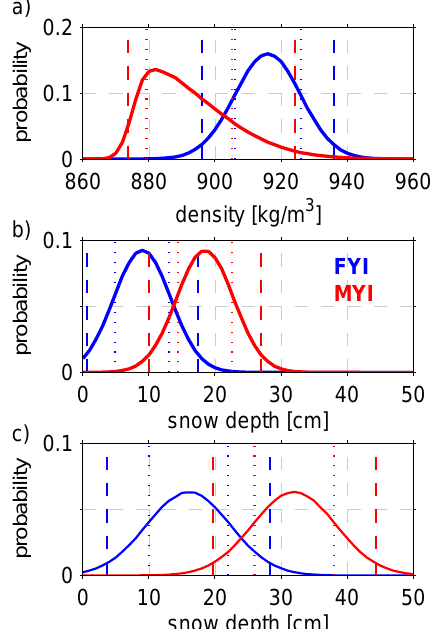
Fig. 2. Probability distributions for sea ice density and snow depth. Distributions are shown separately for first-year ice (FYI) and multi-year ice (MYI). (a) Mean sea ice density, (b) mean snow depth in October/November, and (c) mean snow depth in Febru- ary/March. Snow depth over MYI is based on climatological values from W99, and 50% of this snow depth is used over FYI. Dotted lines indicate the first standard deviation (15 and 85 percentile) and dashed lines the second standard deviation from the mean (2.3 and 97.7